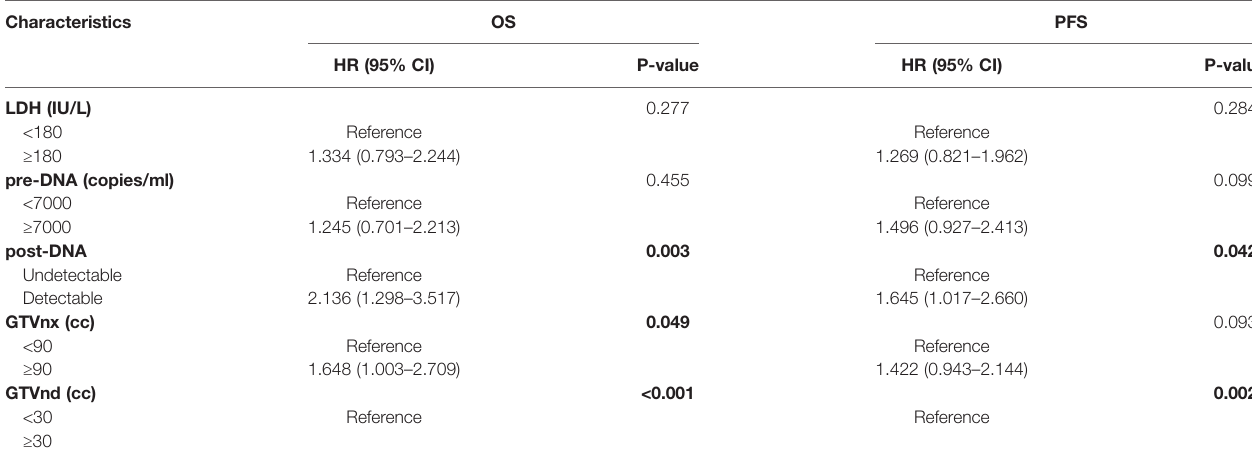
TABLE 3 | Identi fi cation of risk factors of OS and PFS by multivariate Cox models. Characteristics